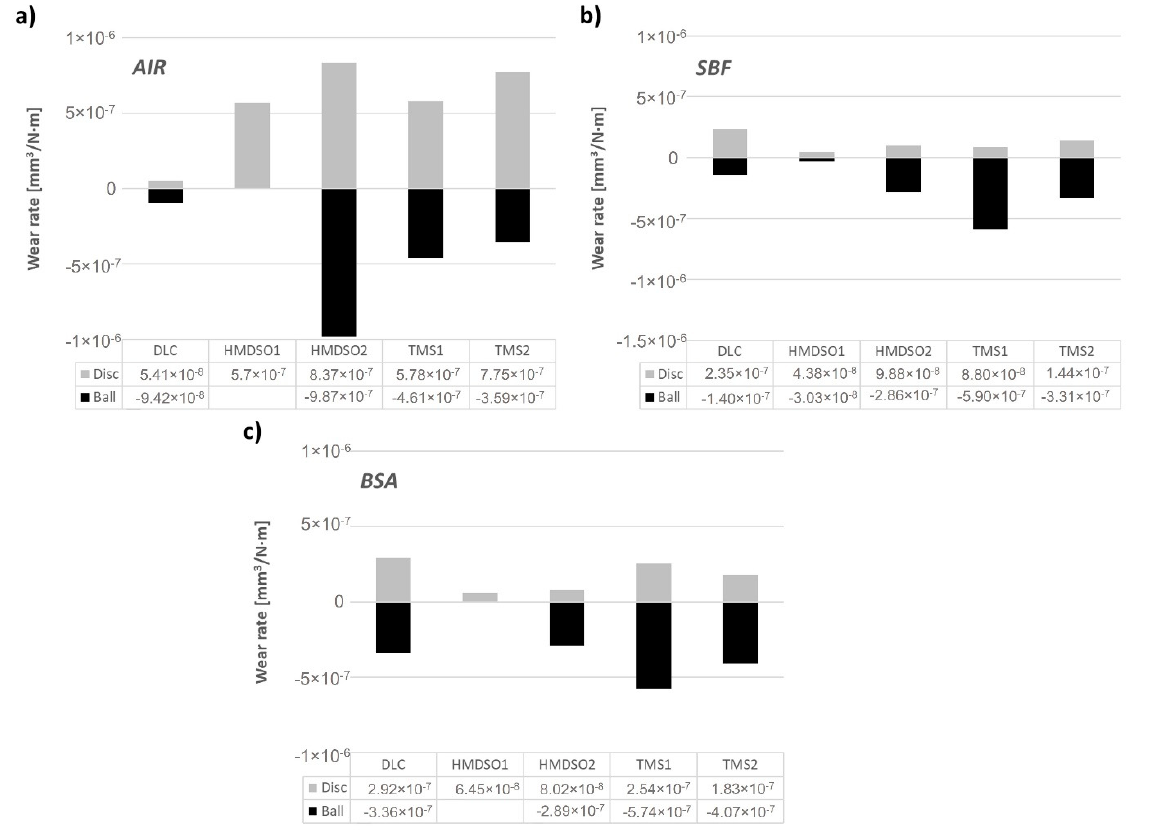
Figure 5. Wear rate of DLC and silicon-incorporated DLC coatings as well as the AISI316L counter- body sliding in ( a ) air, ( b ) SBF, and ( c ) BSA environment. body sliding in ( a ) air, ( b ) SBF, and ( c ) BSA